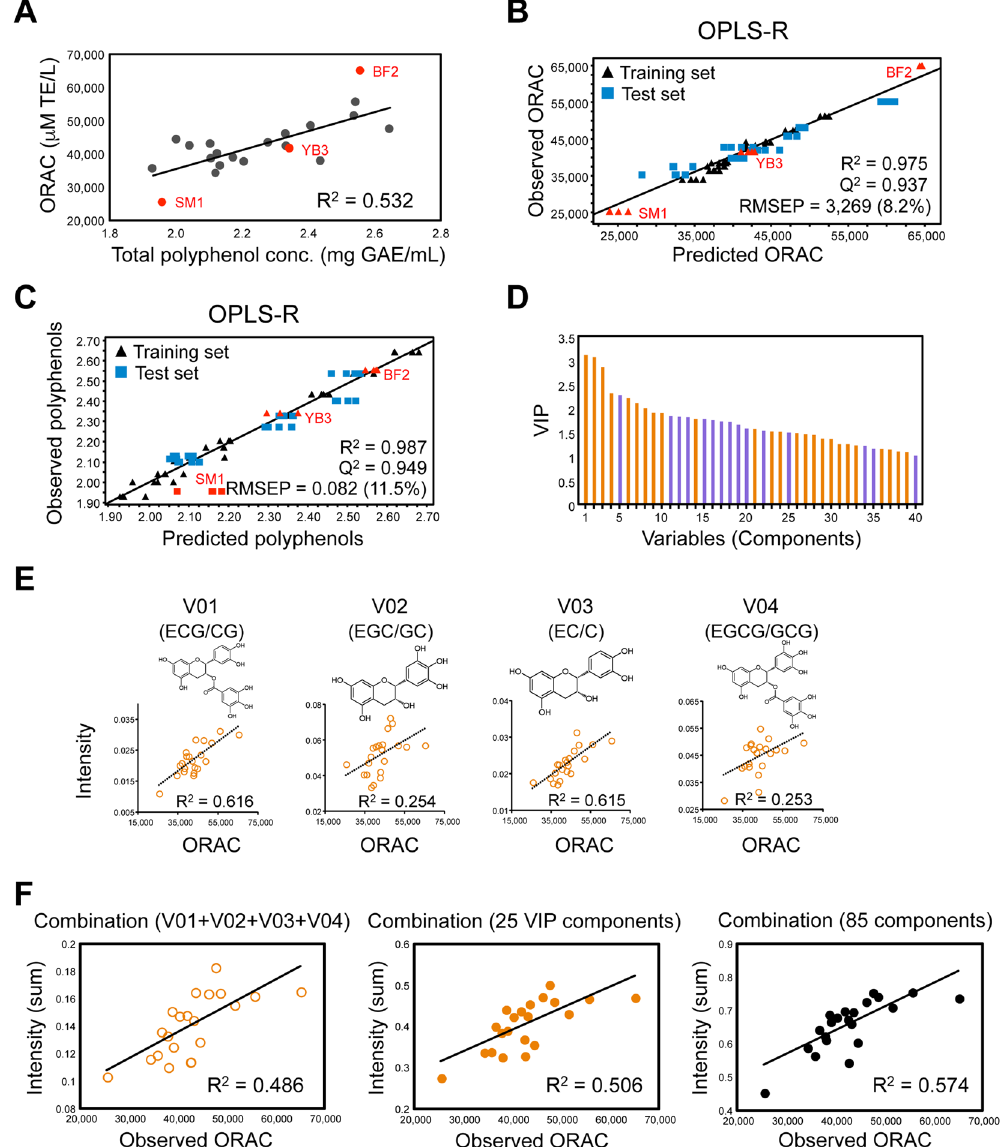
Figure 3. Construction of bioactivity-prediction model to predict the anti-oxidant activity of GTEs based on their composition profiles. ( A ) Correlation between ORAC and total polyphenol content. ORAC values are presented as Trolox equivalents (TE). Total polyphenol contents are presented as gallic acid equivalents (GAE). Models for predicting ( B ) ORAC or ( C ) total polyphenol content were calculated from the MALDI–MS datasets of 21 GTEs, including 13 training (black triangles) and 8 test (blue squares) sets. ( D ) Bar chart showing the influence of variables used to create the ORAC-prediction model for GTEs (Y-axis is the value of variable- importance-in-projection, VIP). Forty variables with large VIP values ( > 1) were extracted. Orange bars indicate positive correlations between the intensity of the component and ORAC. Purple bars indicate negative correlations. ( E ) Correlations between ORAC and the intensity of each of the top-4 components with the largest VIP values ( > 1). ( F ) Correlations between ORAC and the summed abundances of multiple components. Left panel: combination of the above-mentioned top-4-VIP components. Middle panel: combination of the 25 positively correlated components with the largest VIP values ( > 1). Right panel: combination of all 85 positively correlated components from among the 149 total